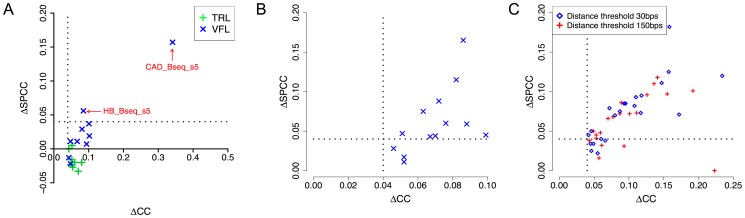
DNA accessibility data provides clues about mechanisms of secondary TF action.
A. Correlation coefficient between ChIP scores and STAP predictions, before and after “partialing out” the effect of accessibility scores (ΔCC and ΔSPCC respectively). Shown here are the effects of VFL and TRL motifs, in cooperative binding mode. Only cases where ΔCC was significant are shown. Dotted lines mark a ΔCC (or ΔSPCC) value of 0.04. B. All cases of significant cooperative influence of secondary motifs other than VFL, TRL, examined before (ΔCC) and after (ΔSPCC) “partialing out” the effect of accessibility scores. Only cases where ΔCC was significant and the secondary TF gene was in the top 10–15% of expressed genes are shown. C. All cases of antagonistic influence by secondary motifs, examined before and after “partialing out” the effect of accessibility scores.